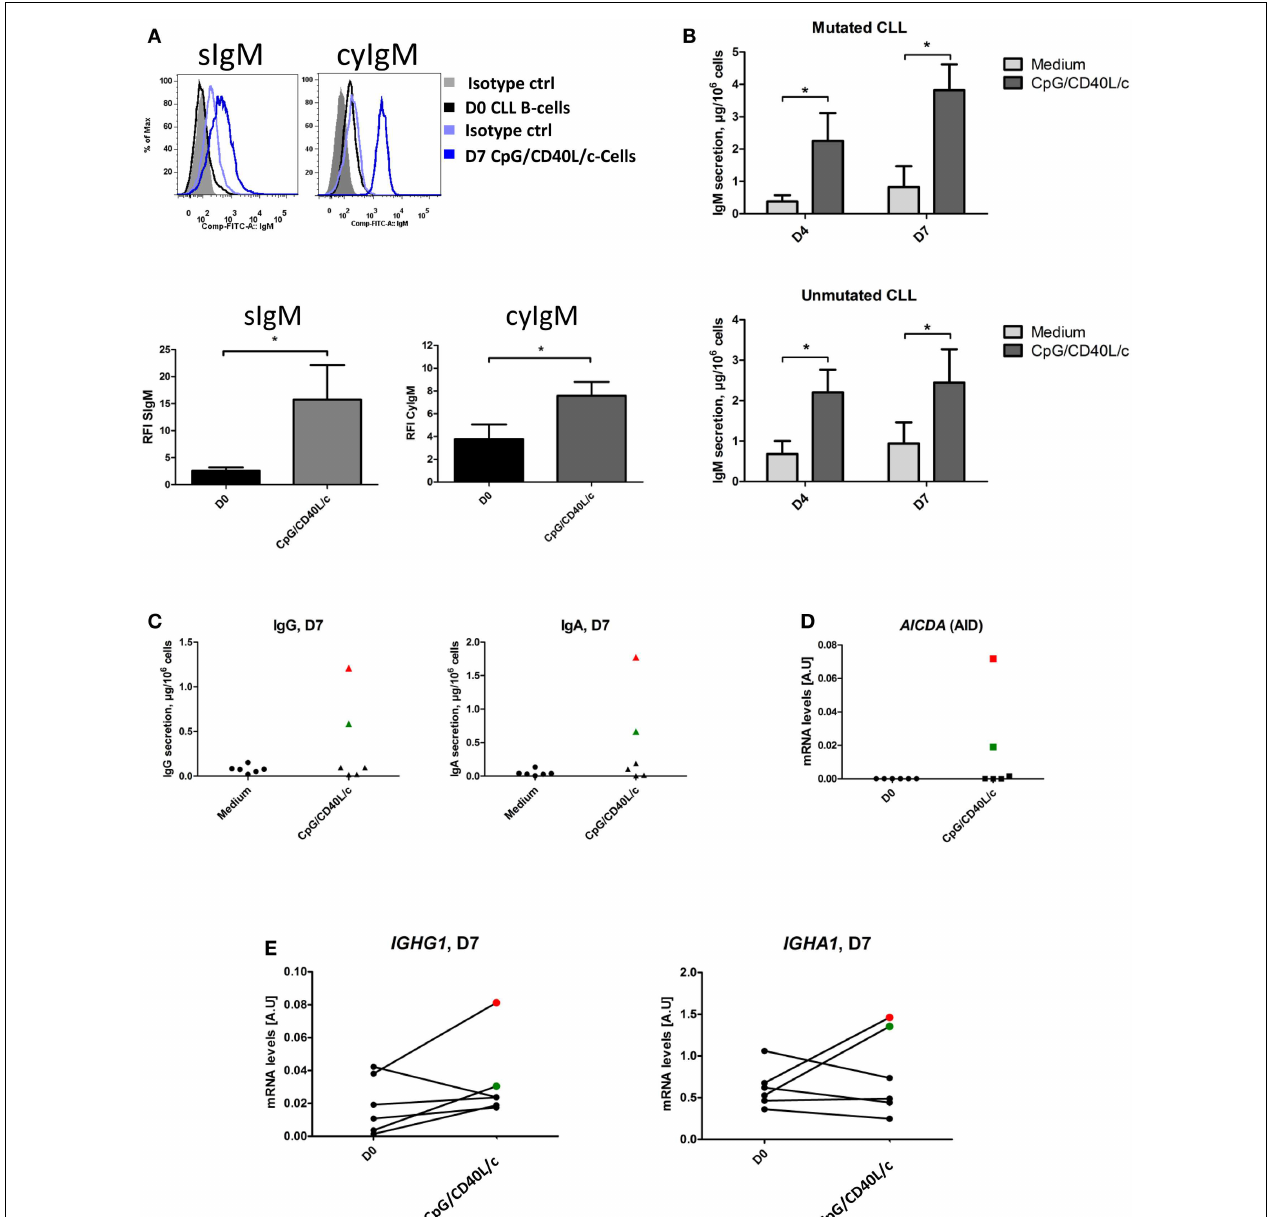
and three unmutated CLL samples. (C) Culture supernatants were harvested on D7. Secreted IgG and IgA levels were assessed with an ELISA.The red and green point correspond to CLL samples #4 and #10, respectively. (D) The relative expression of AICDA in CLL B-cells on D0, compared with CpG/CD40L/c-stimulated cells on D7.The data were calculated according to the relative 2 – ∆ CT method. (E) The transcriptional expression of IGHG1 and IGHA1 in CLL B-cells on D0, compared with CpG/CD40L/c-stimulated cells on D7. Quantitative real-time PCR analysis was performed on total RNA extracted from cells at D0 and D7. IGHG1 and IGHA1 mRNA expression are upregulated in cells in which IgG and IgA class-switch recombination occurred [the red (CLL#4) and green (CLL#10) points].The statistical significance was calculated in a paired t -test: * p <